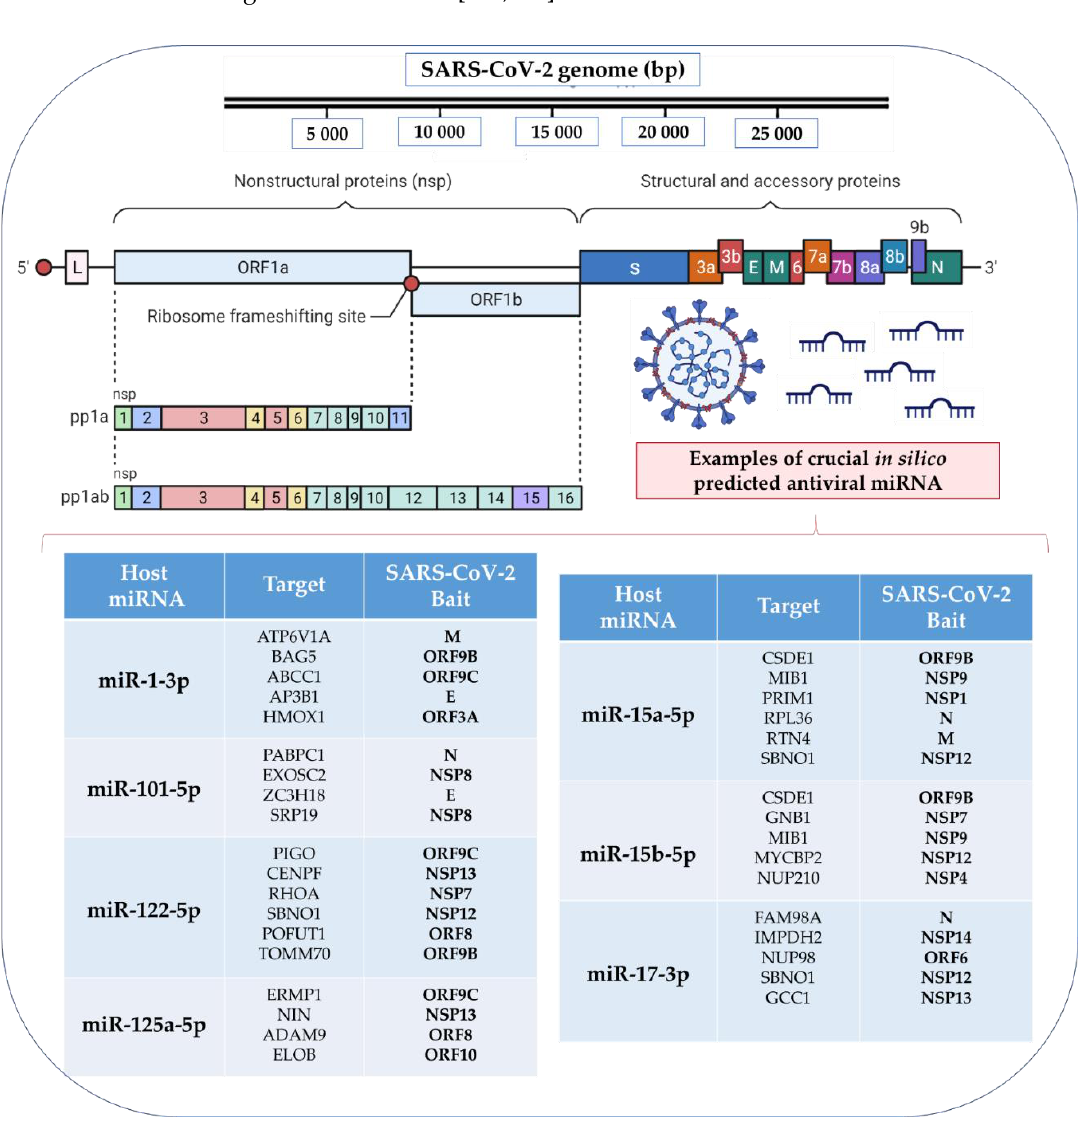
Figure 5. Schematic key elements of the SARS-CoV-2 genome and a reference to the in silico analysis by Sardar et al. [180] of host's miRNAs with antiviral activity, their targets, and virus baits. Among others presented, five major genes (HMOX1, DNMT1, PLAT, GDF1, and ITGB1) directly targeting the SARS-CoV-2 ORF3a and ORF8 proteins were already described to play a role in modulating antiviral immunity and epigenetics [182–184].